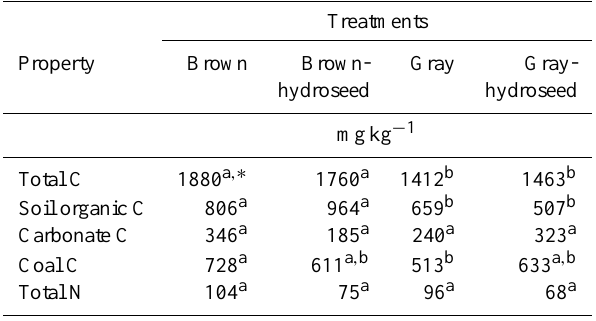
Table 5. 2008 and 2012 soil properties of samples from four soil treatments at the Arch–Birch River mine in Webster County, WV (Wilson-Kokes et al., 2013b).